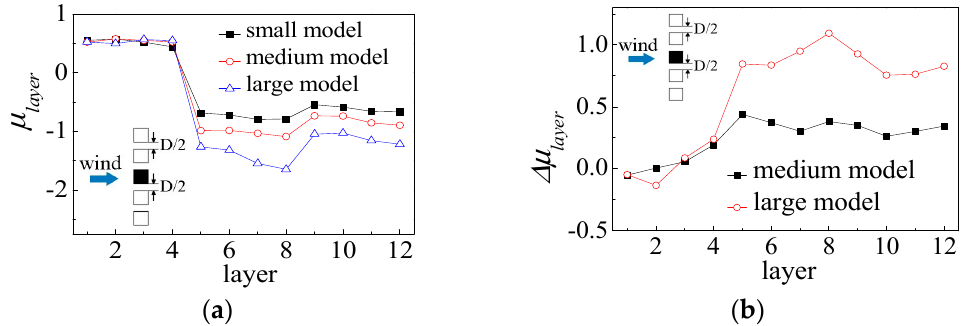
Figure 14. Wind tunnel test results of test condition 5. ( a ) Layer pressure coefficient; ( b ) relative error of layer pressure coefficient.